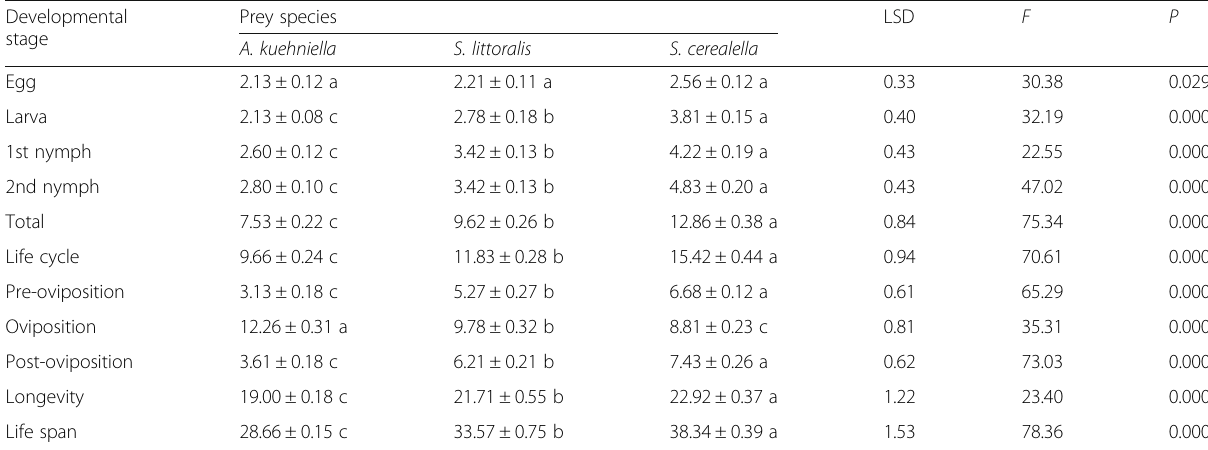
Table 3 Duration (in days) of Neosiulus cucumeris females fed on eggs of Anagasta kuehniella , Spodoptera littoralis , and Sitotroga cerealella and incubated at 27 °C and 70% RH Developmental stage